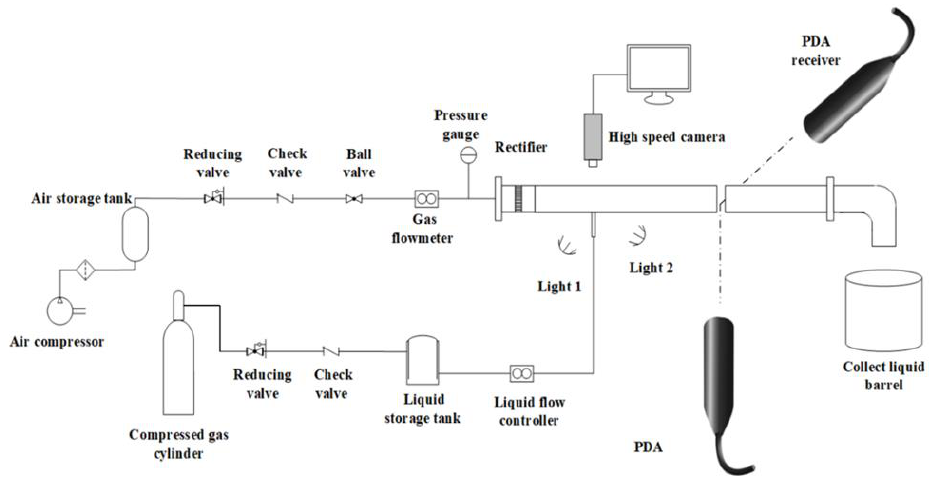
Figure 1. Schematic of experimental apparatus.